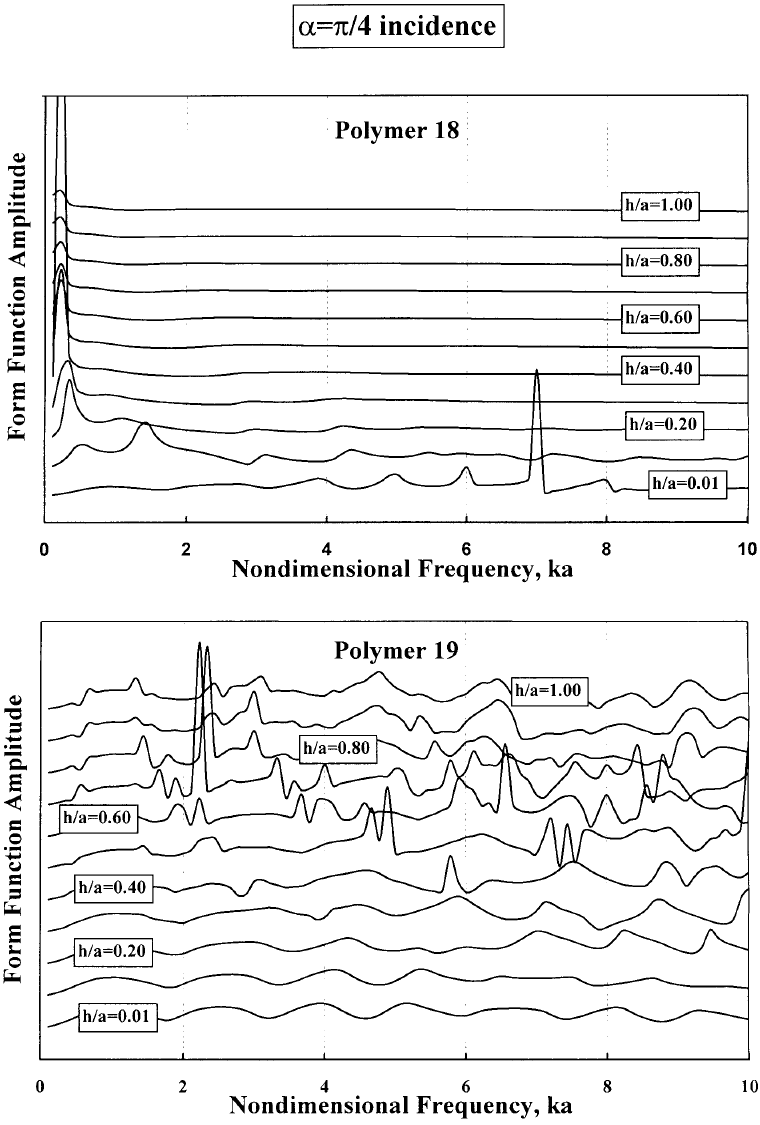
Fig.9. Variation of the formfunction forthe fluid-filled cylindrical viscoelastic shell with the shell thickness atoblique wave incidence ( α = π/ 4